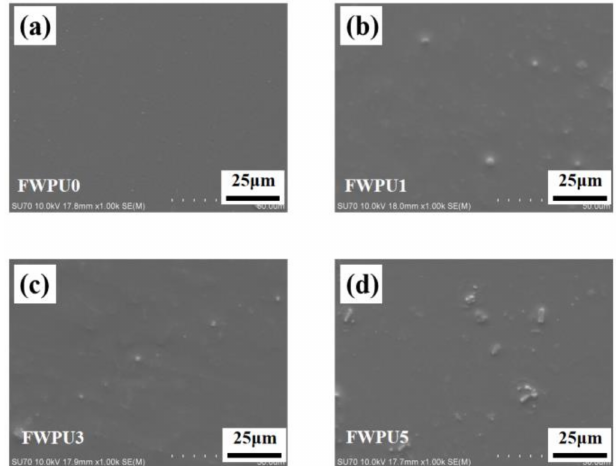
Figure 7. SEM images of FWPU films with different POSS contents, FWPU0 ( a ), FWPU1 ( b ), FWPU3 ( c ), FWPU5 ( d